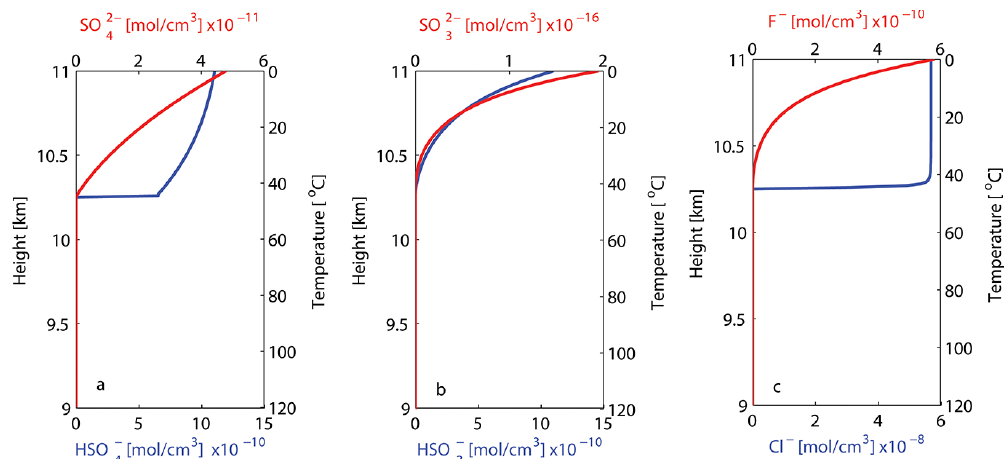
and SO 2 − , which form due to 4 2